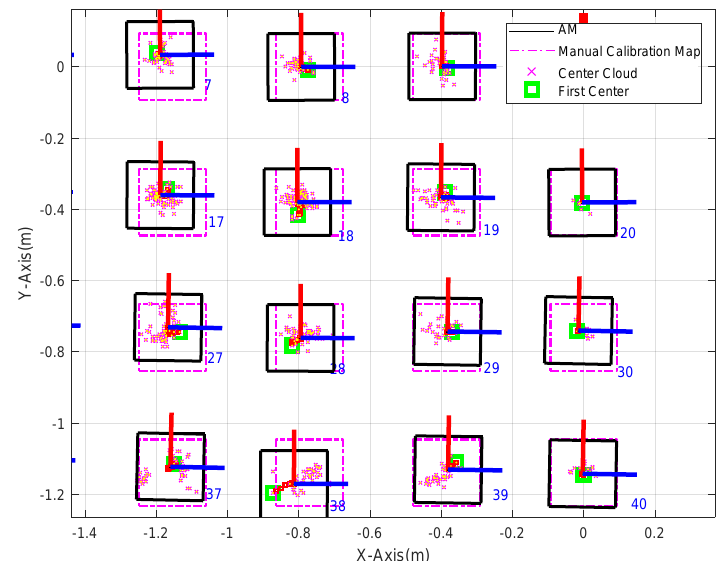
Figure 7. Local Enlarged Results of Figure